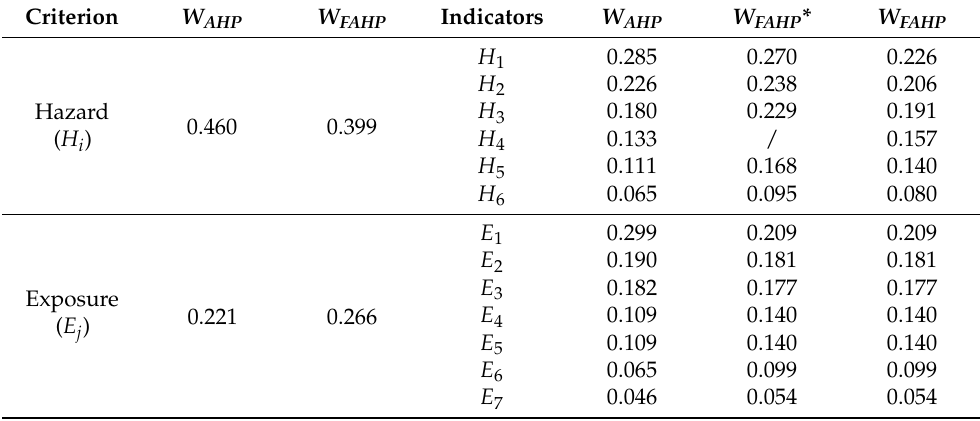
Table 5. The weight of each risk indicator was calculated based on the AHP and FAHP